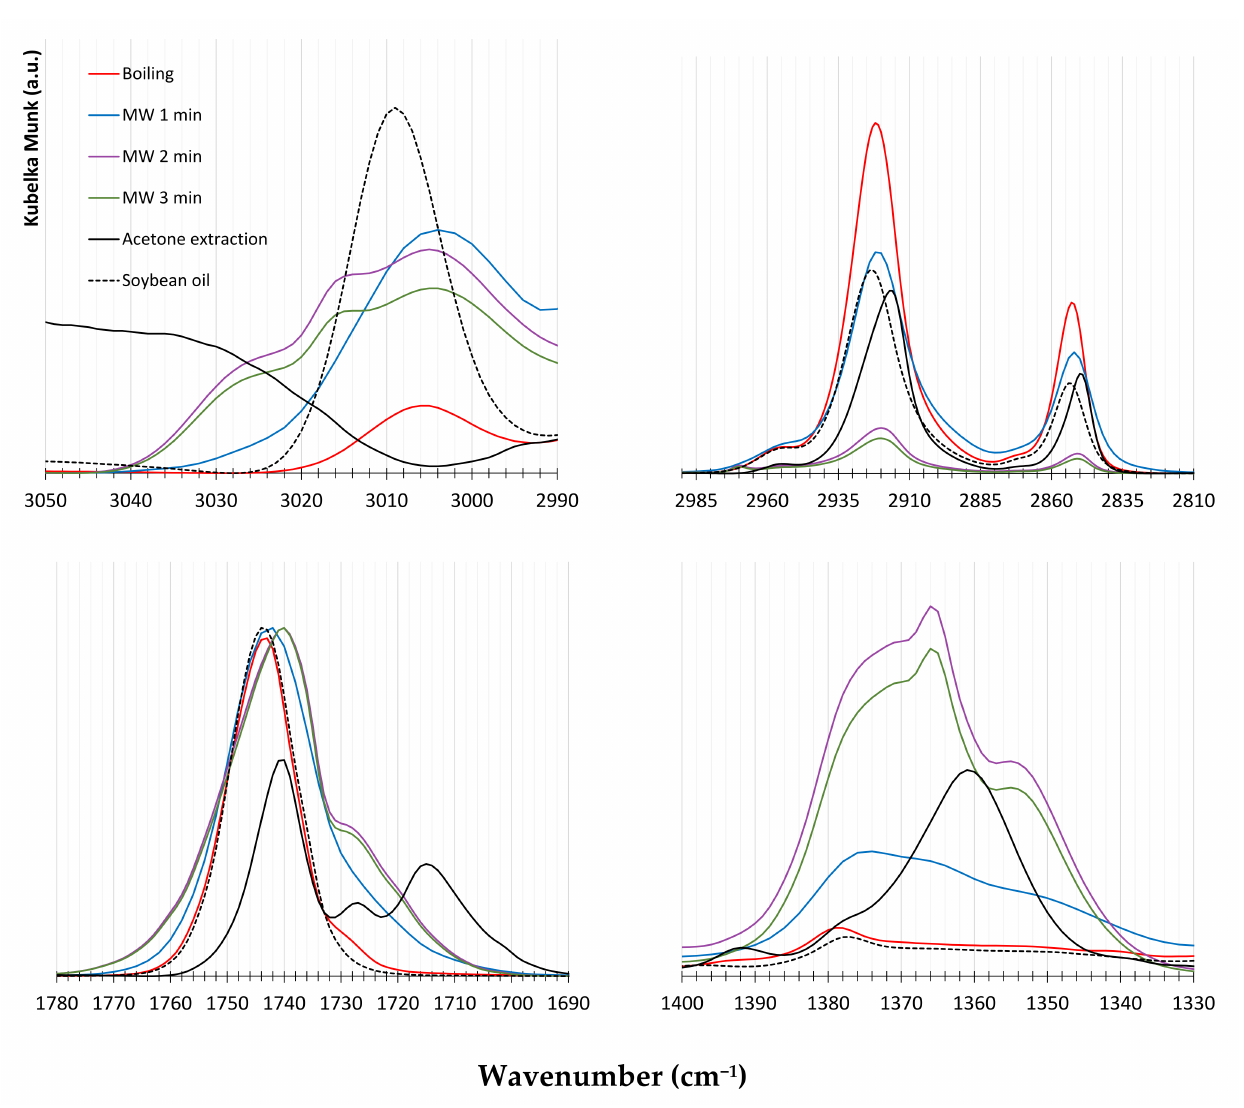
Figure 7. ATR-FTIR spectra of tallows, extracted using the various procedures, with SBO as a